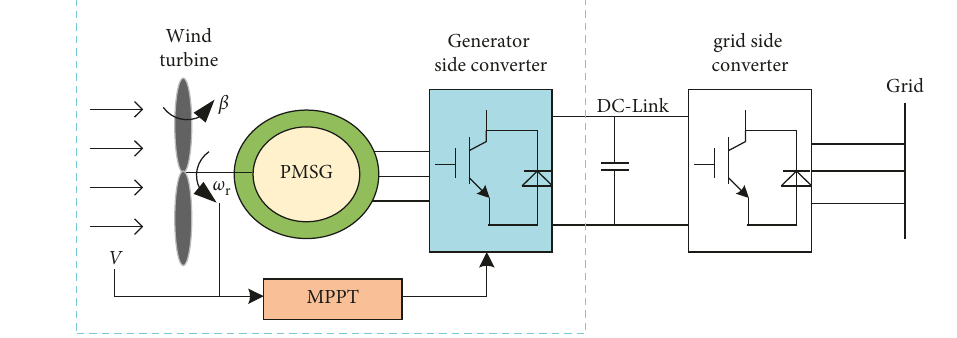
Figure 1: PMSG wind power generator system structure.